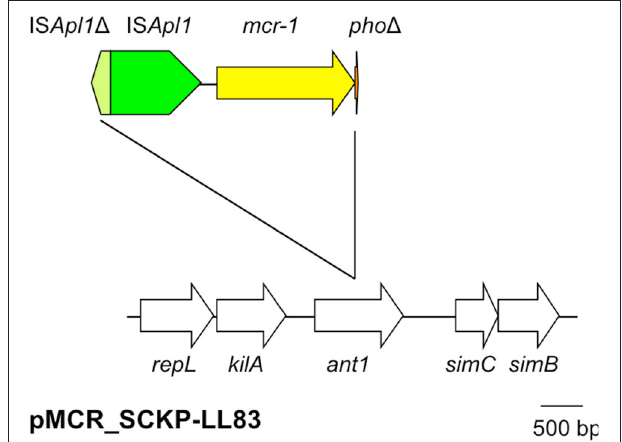
FIGURE 1 | The genetic context of mcr-1 on pMCR_SCKP-LL83. The IS Apl1 1 -IS Apl1 - mcr-1 - pho 1 structure is inserted into ant1 but without